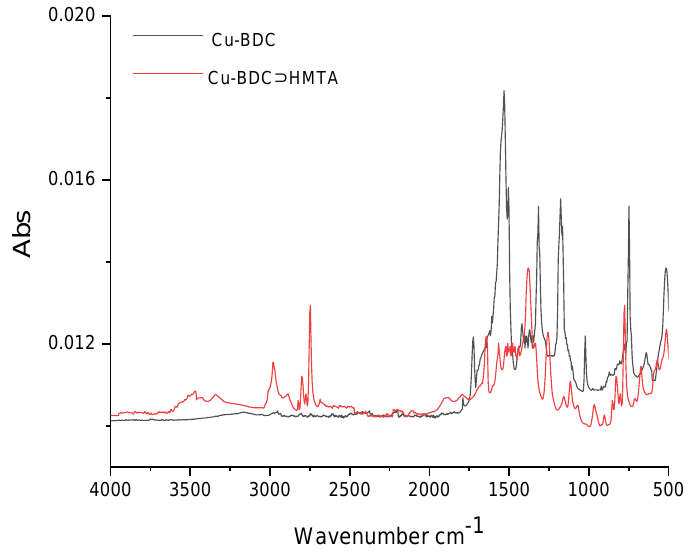
Figure 3. FTIR spectra for Cu-BDC and Cu-BDC ⊃ HMTA.